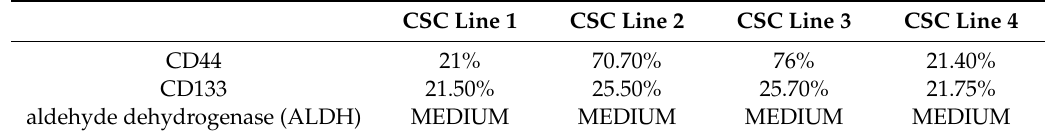
Table 1. Typical stem-cell markers evaluated on tumor sphere cultures.